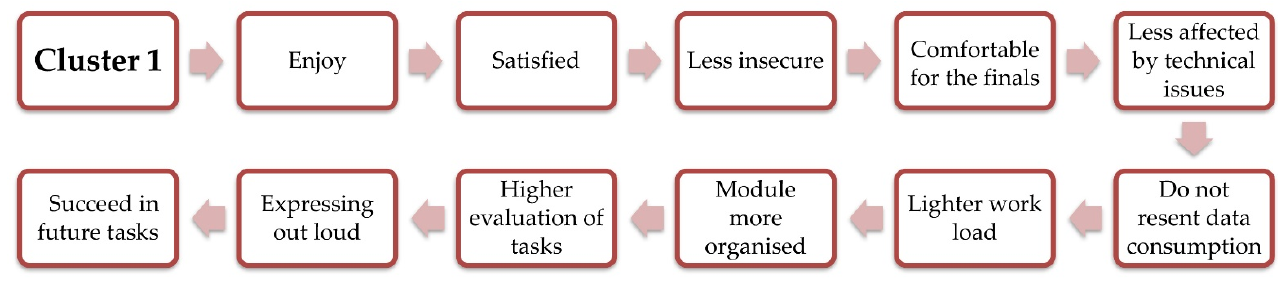
Figure 7. Characteristics of the differentiation of Cluster 1.